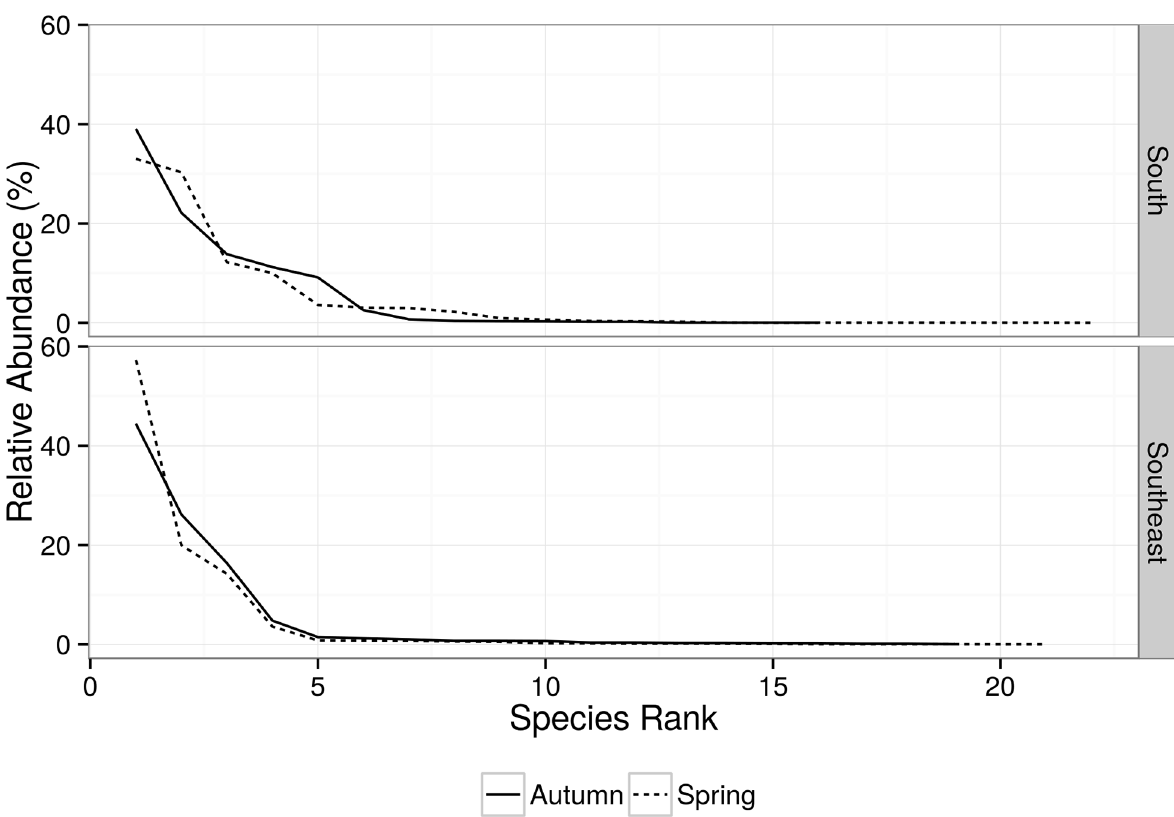
Fig 3. Whittaker plot of the relative species abundance by each area (South, Southeast) and season (Spring, Autumn). This plot considers the relative abundance as a proportion of the total number of individuals of each species in relation to the total number of individuals of all species.